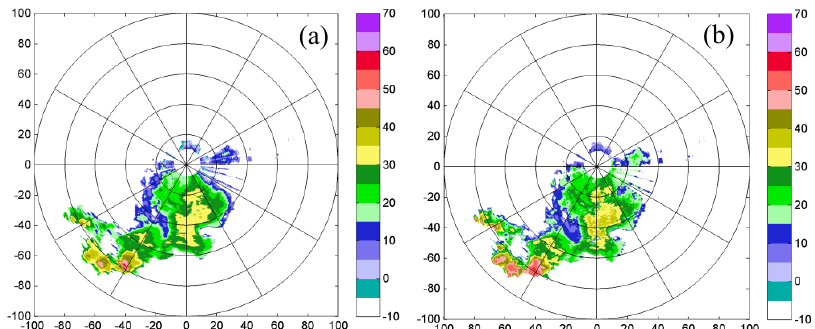
Figure 14. ( a ) Corrected reflectivity at X-band; ( b ) the intrinsic reflectivity at X-band.